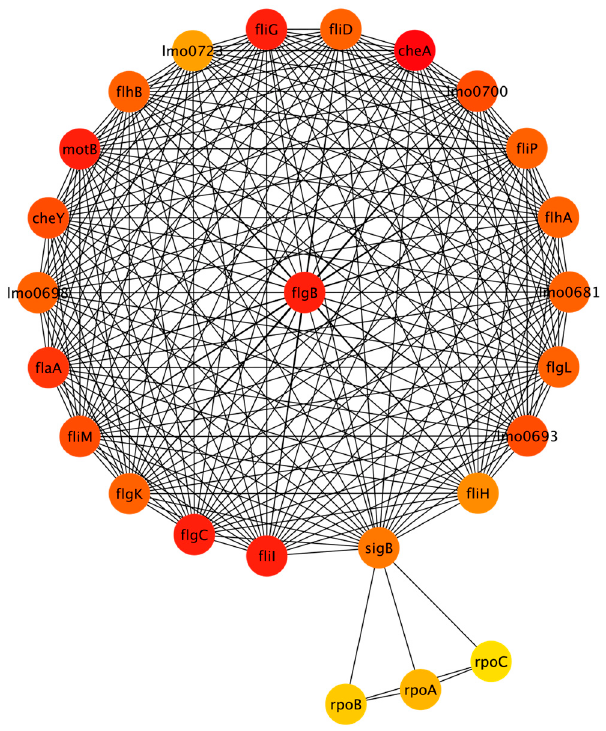
Figure 6. Combined network depicting top 25 nodes (refer to Table S4 for additional information about each protein).